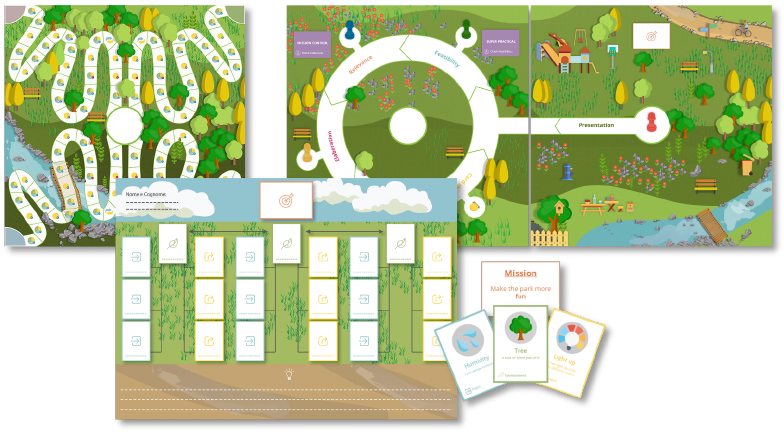
Figure 5. Boards and cards of the physical SNaP.